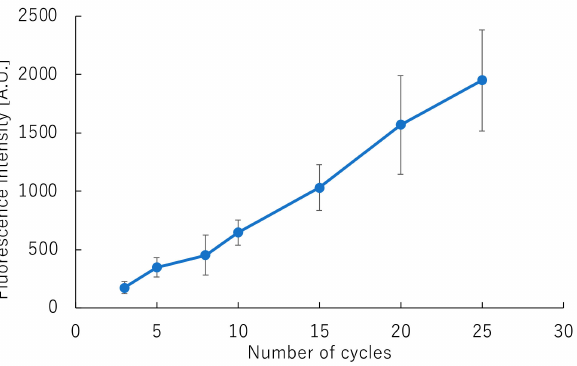
Figure 6. Correlation between fluorescence intensity and the number of fluorescence-labeling